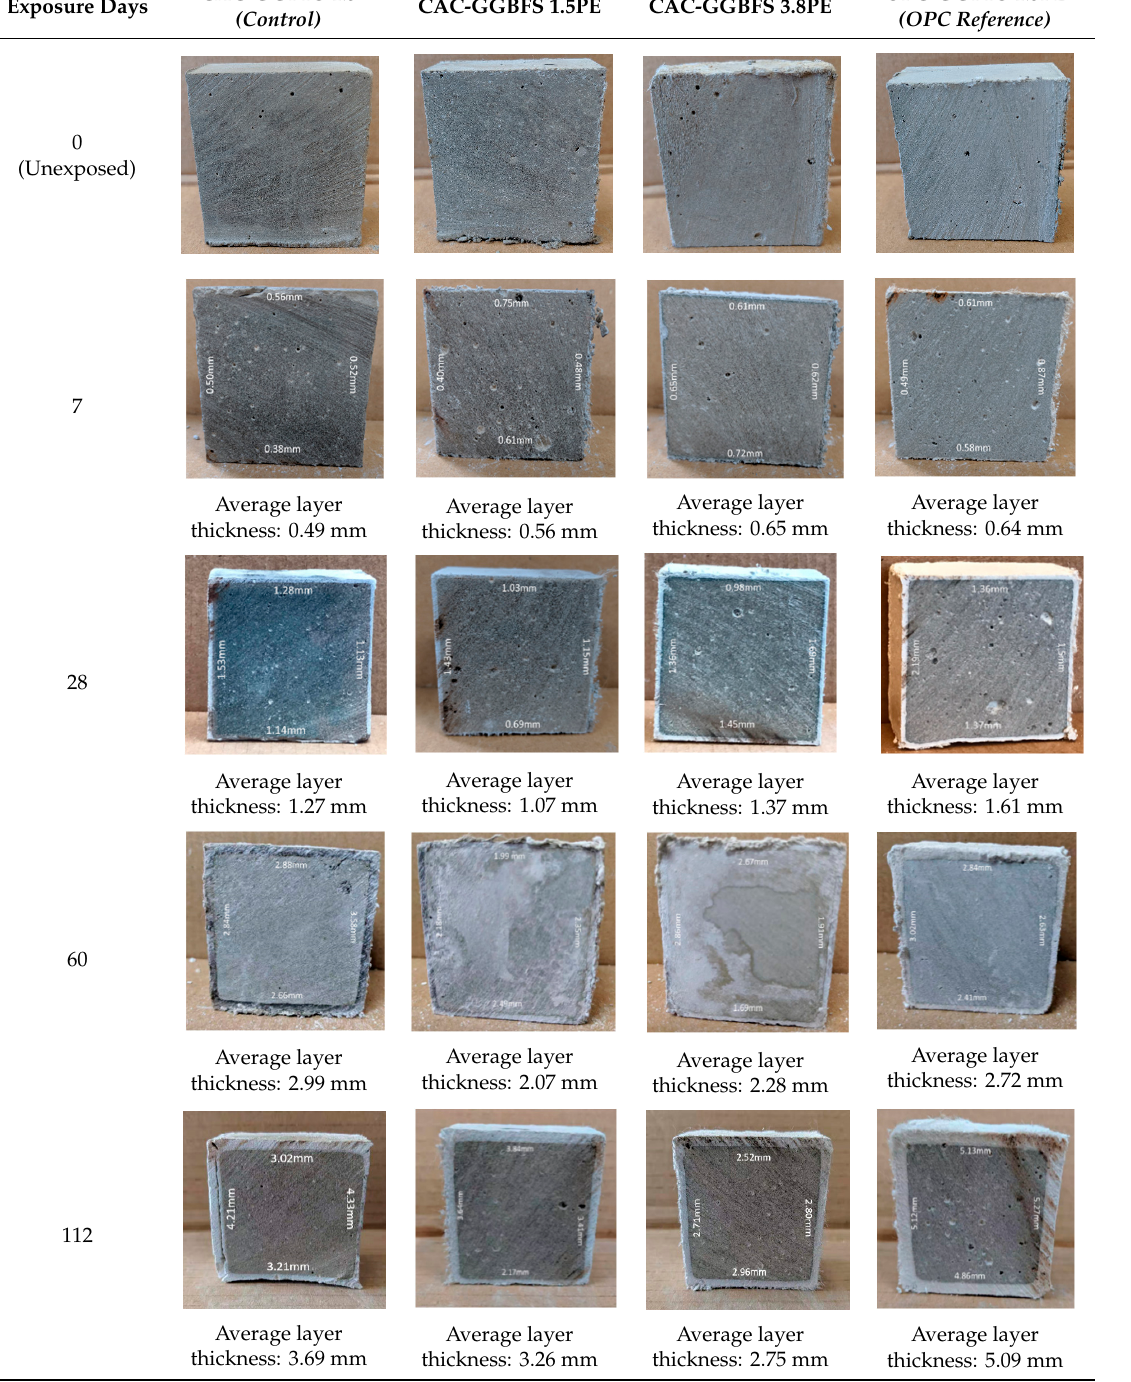
Table 4. Change of cross-section at different age after acid exposure.